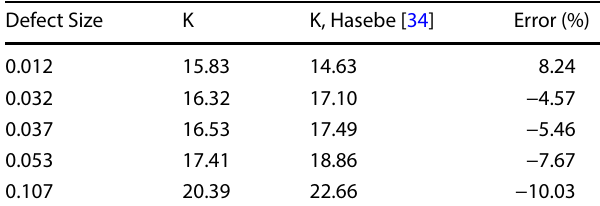
Table 4 5× LR stress intensity factors and errors for 60-degree v-notch